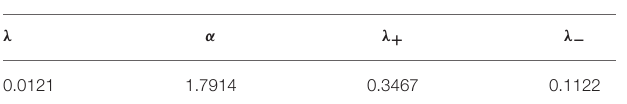
TABLE 8 | Minimal entropy parameters (CTS).